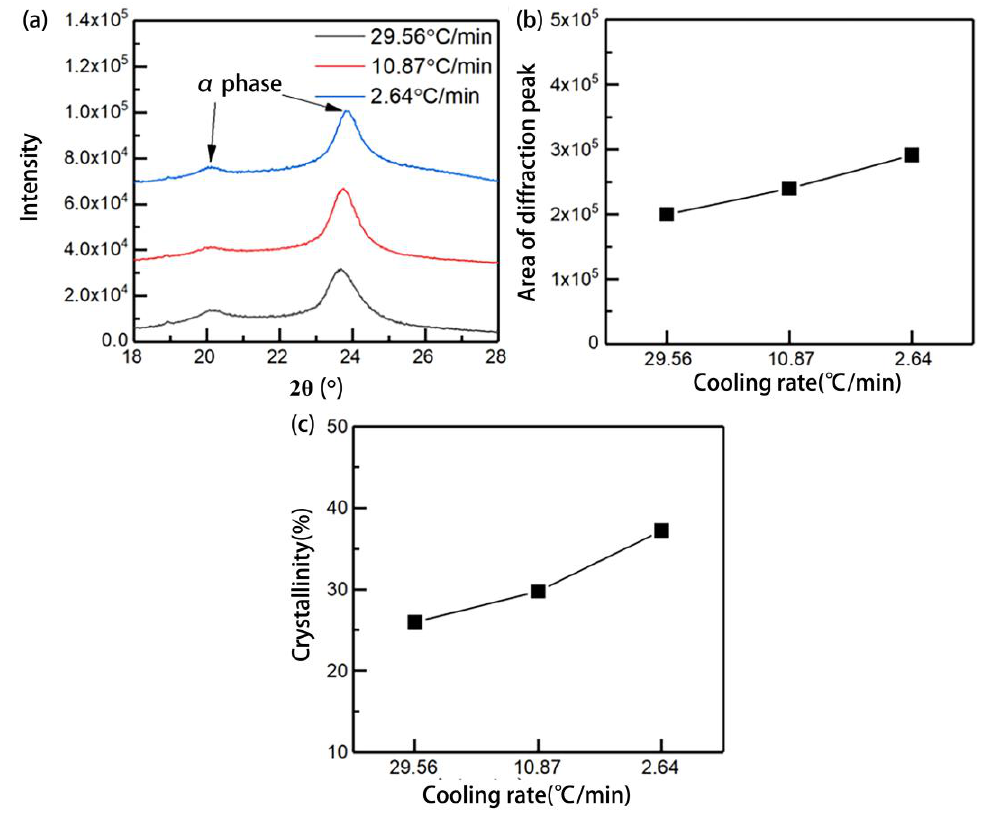
Figure 10. XRD results for different cooling rates: ( a ) XRD test diffractograms; ( b ) area of diffraction peak; ( c ) crystallinity of the sample.